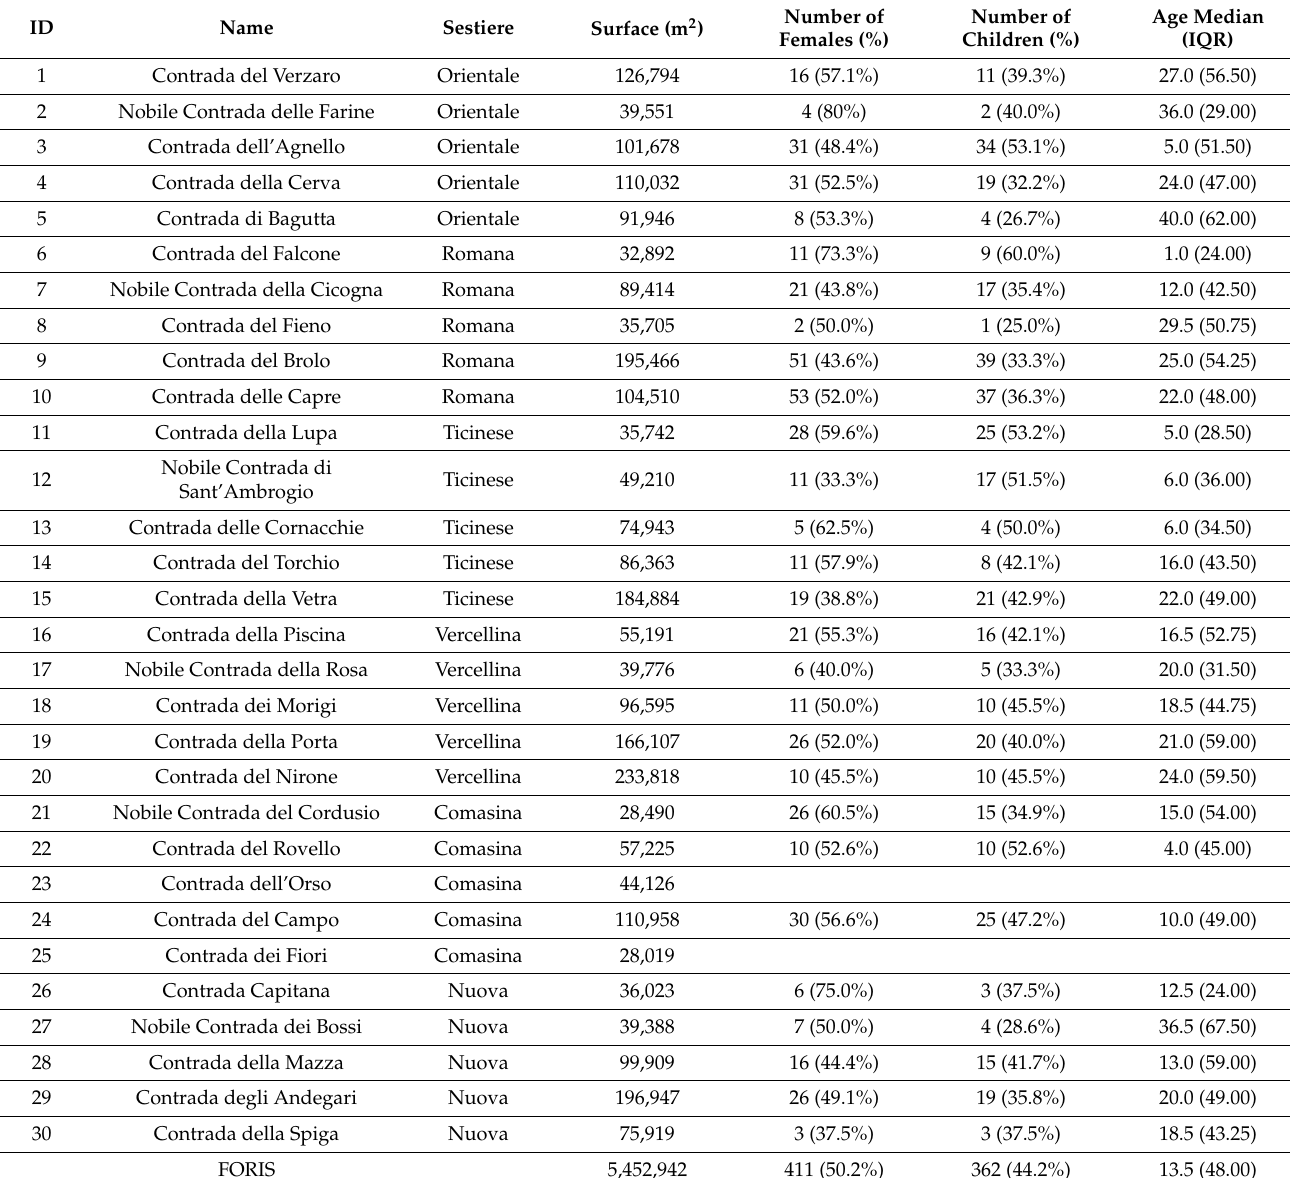
Table 1. The distribution of gender and age in each Contrada and the foris